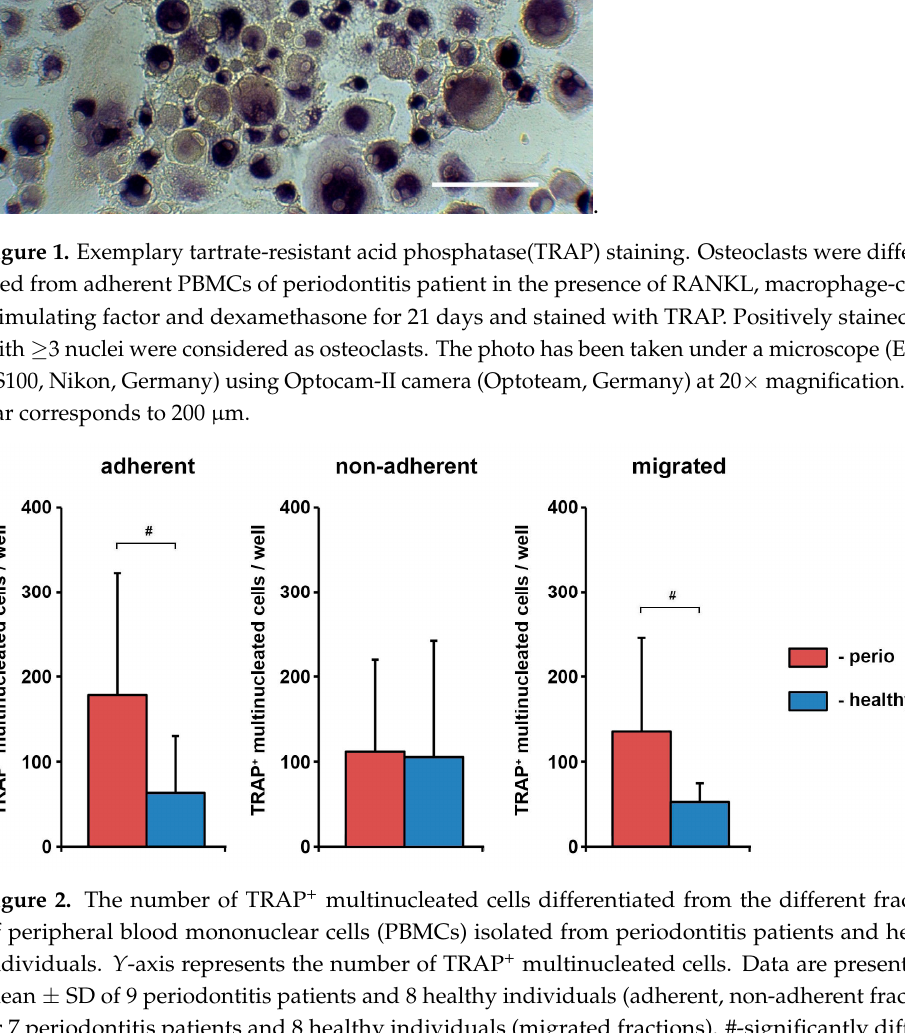
± SD of 9 periodontitis patients and 8 healthy individuals (adherent, non-adherent fractions) or 7 periodontitis patients and 8 healthy individuals (migrated fractions). #-significantly different between periodontitis patients and healthy individuals.